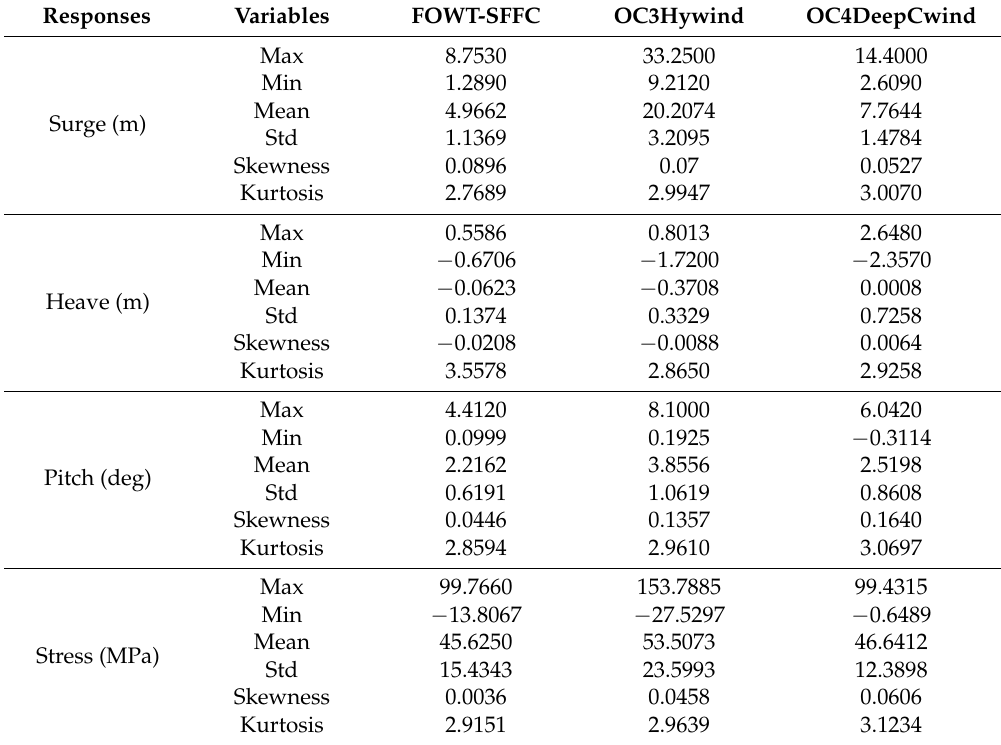
Table 10. Statistics of foundation motions and tower base stress under